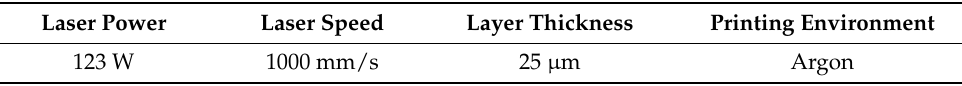
Table 2. Parameters of the SLM manufacturing process [52].